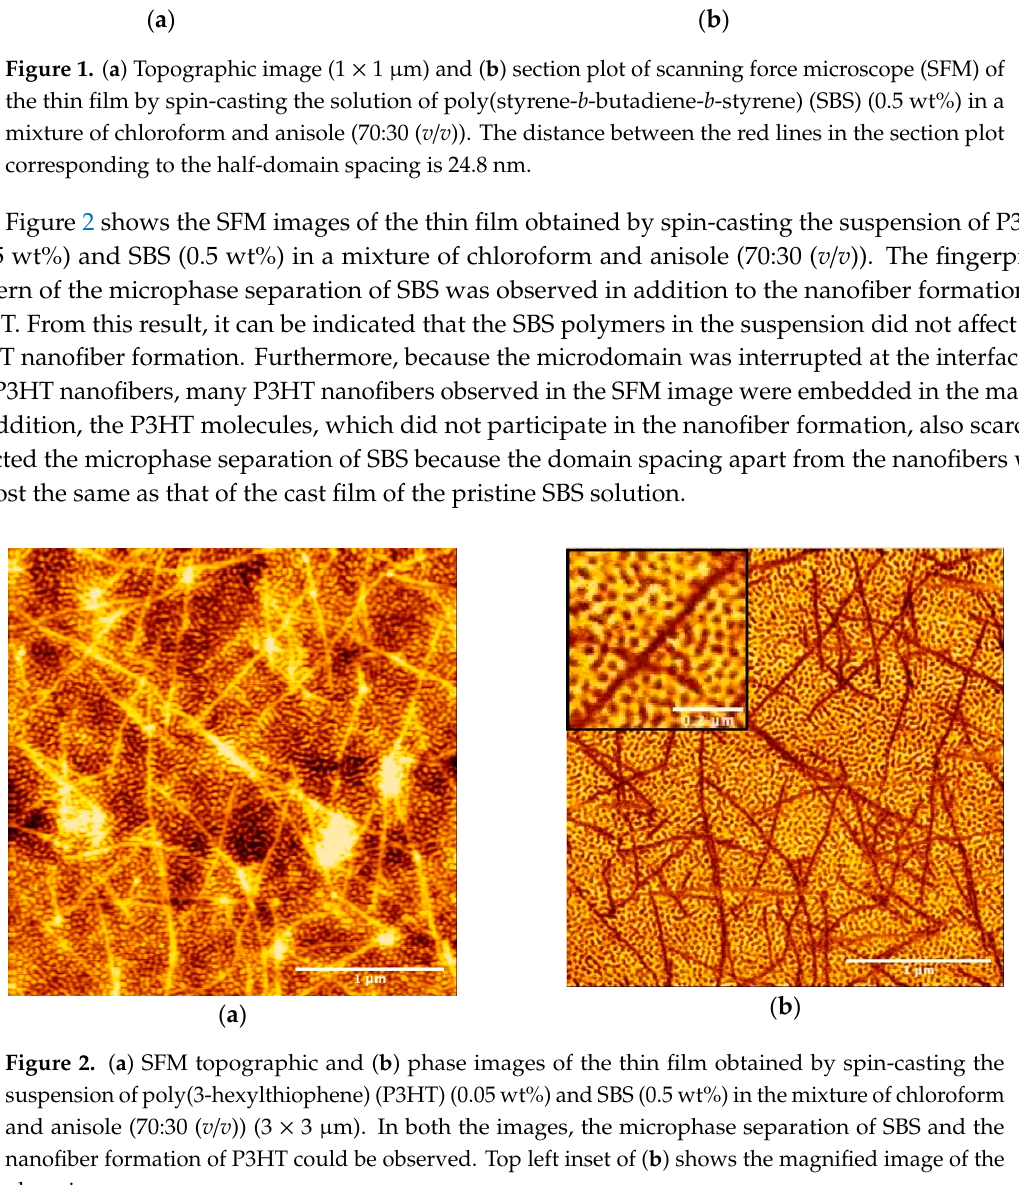
Figure 1. ( a ) Topographic image (1 × 1 μ m) and ( b ) section plot of scanning force microscope (SFM) of the thin film by spin-casting the solution of poly(styrene- b -butadiene- b -styrene) (SBS) (0.5 wt%) in a mixture of chloroform and anisole (70:30 ( v / v )). The distance between the red lines in the section plot corresponding to the half-domain spacing is 24.8 nm.